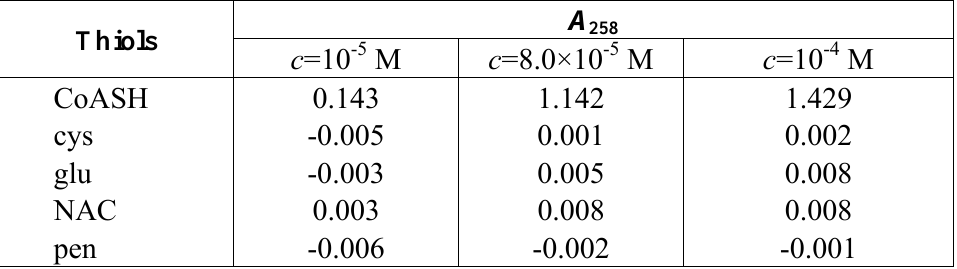
Table 3. Absorbance of different thiols at 258